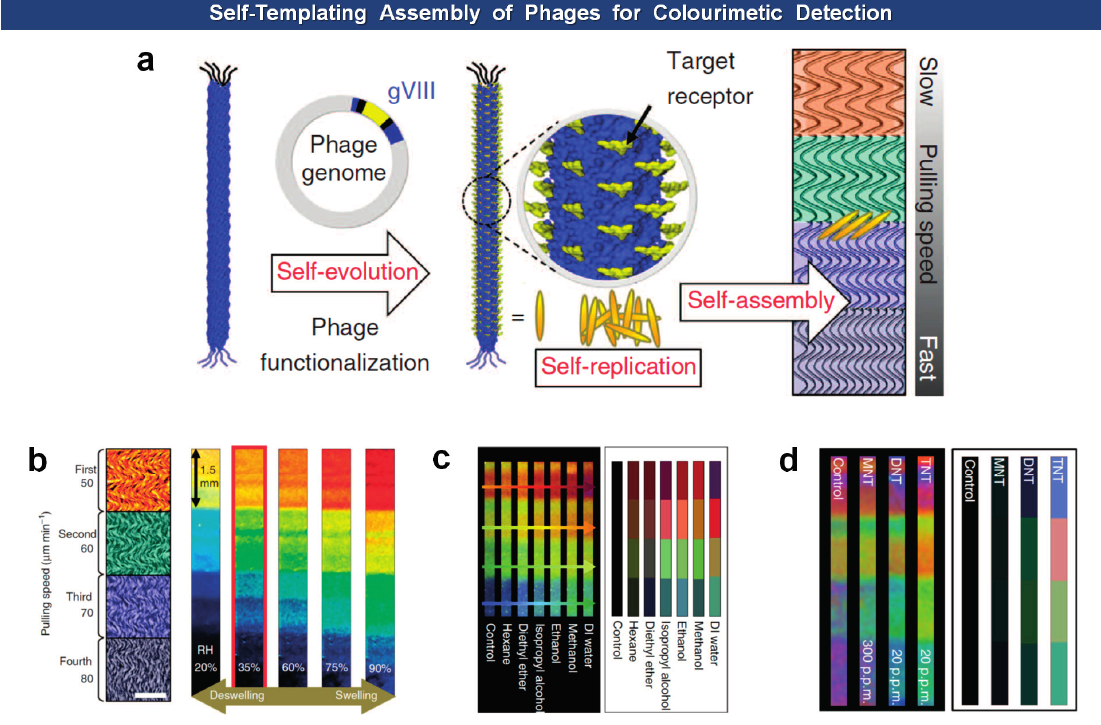
Figure 11. Phage Litmus as colourimetric sensors. ( a ) Schematics for the generation of self-templating assembly of functionalized phages onto a substrate with varying deposition speed. Colour changes of the Phage Litmus due to humidity ( b ); VOCs ( c ); and TNT ( d ) [105] (Copyright © 2014 Macmillan Publishers